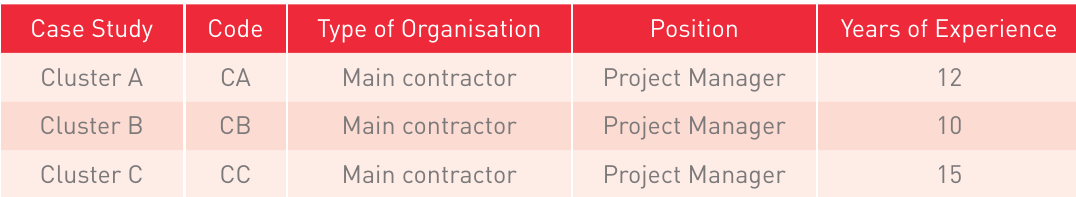
Table 4. Profile of participants taking part in Phase Two interviews (Affected Construction Site